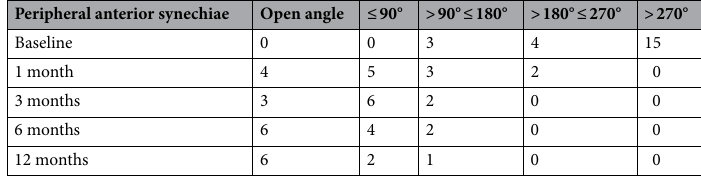
Table 4. Peripheral anterior synechiae in patients before and after